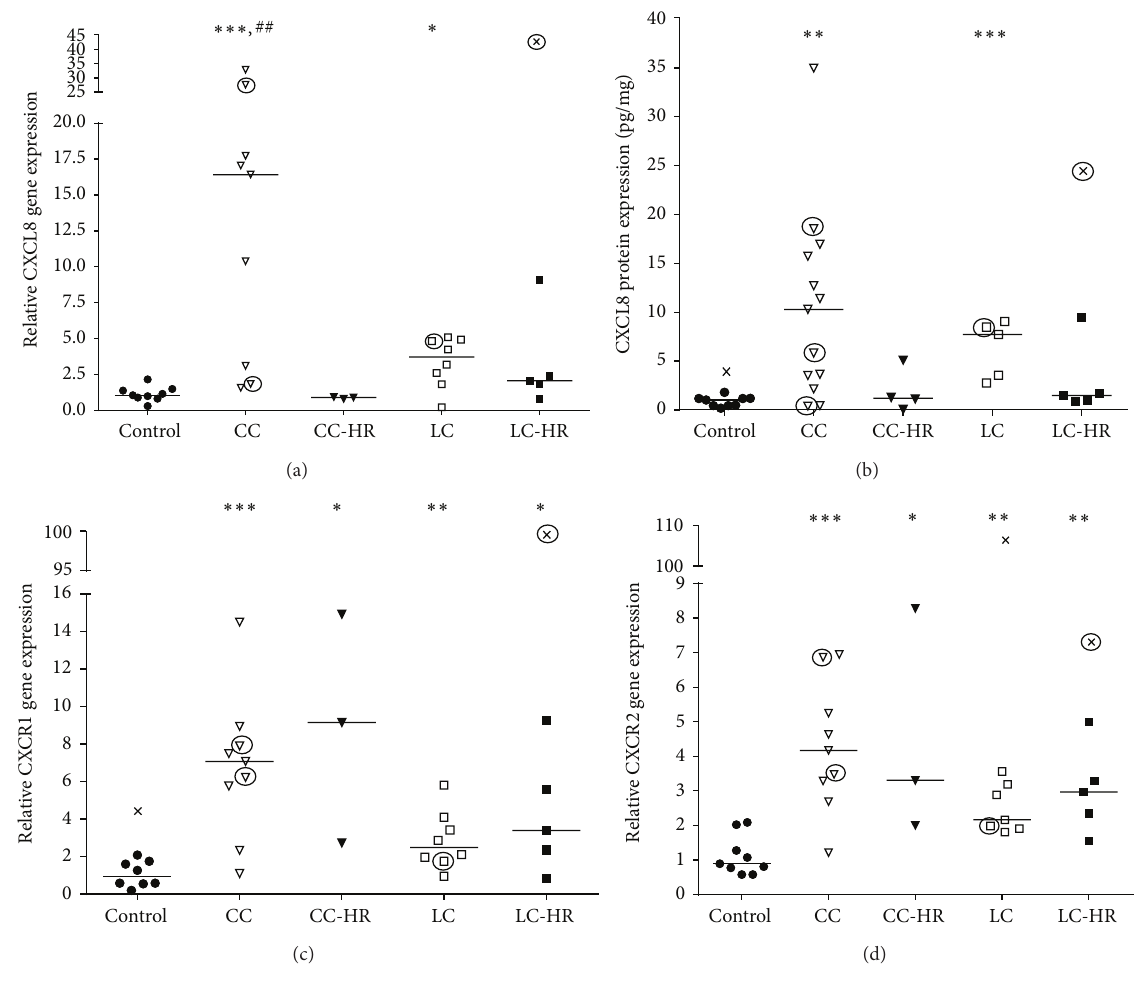
Figure 4: Relative gene and protein expressions of the neutrophil recruiting chemokine CXCL8, as well as gene expression of its receptors CXCR1 and CXCR2. Each symbol represents one patient and the medians of the values are depicted as a line. Statistical outliers are marked as crosses (X) and budesonide treated patients are encircled. ∗ 𝑃 < 0.05 , ∗∗ 𝑃 < 0.01 , and ∗∗∗ 𝑃 ≤ 0.001 versus controls and # 𝑃 < 0.05 , ## 𝑃 < 0.01 versus